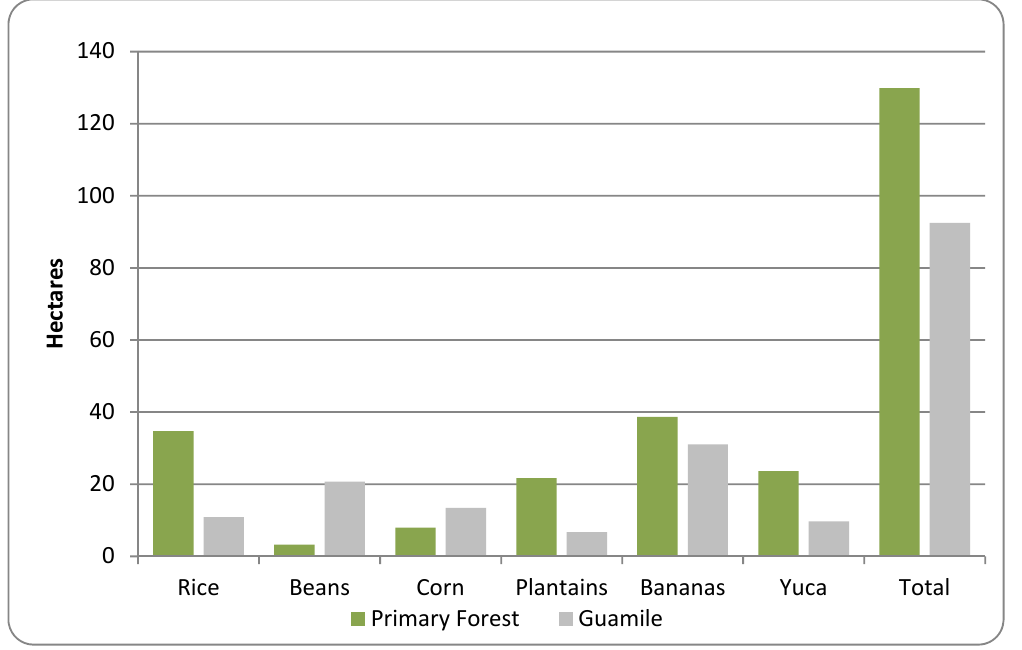
Figure 3. Area of subsistence crops planted by type of land cover cleared (n =